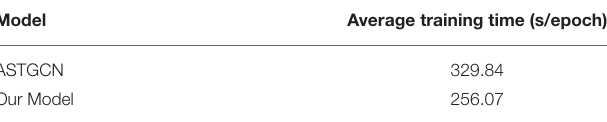
TABLE 3 | Training efficiency